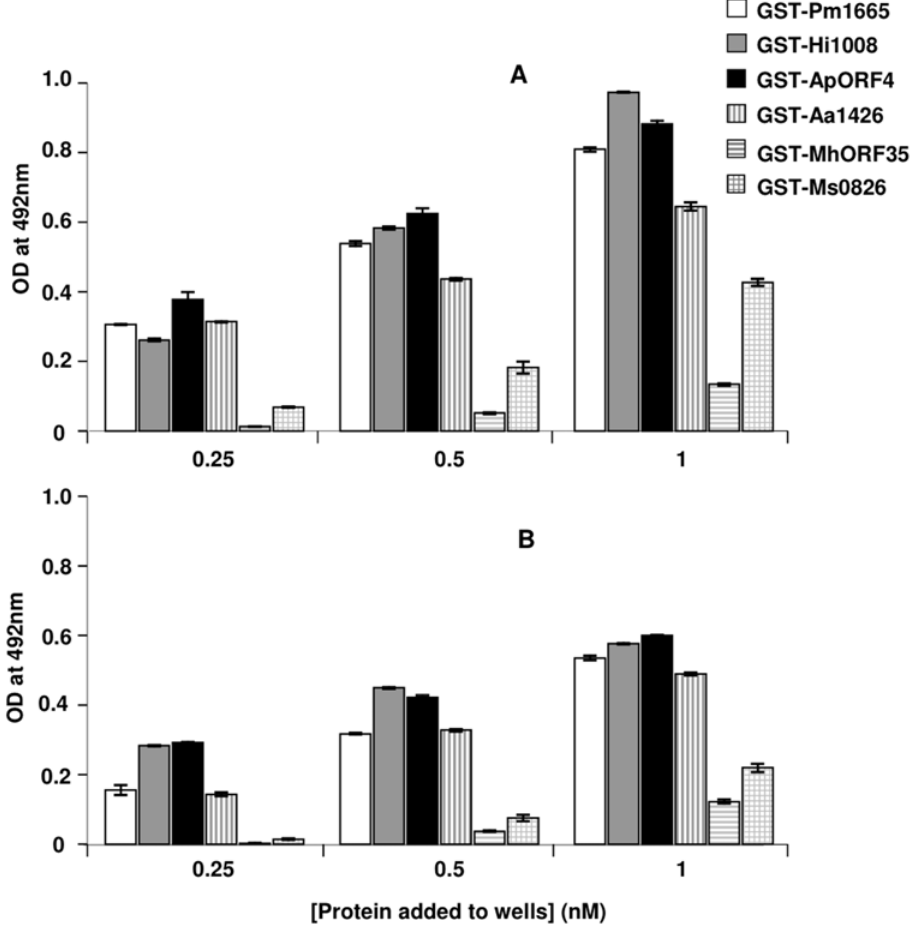
Figure 7. Binding of homologs of ComE1 from P.multocida (PM1665), H.influenzae (Hi1008), A.actinomycetemcomitans (Aa1426), A. pleuropneumoniae (APL_1406), M.haemolytica (MhORF35) or M.succiniproducens (Ms0826) expressed as GST-fusions to pUC19 DNA (A) or Fn (B) measured by direct binding ELISA. Optical density values at 492 nm were converted to estimates of the concentration of bound protein by reference to a standard curve for each protein.